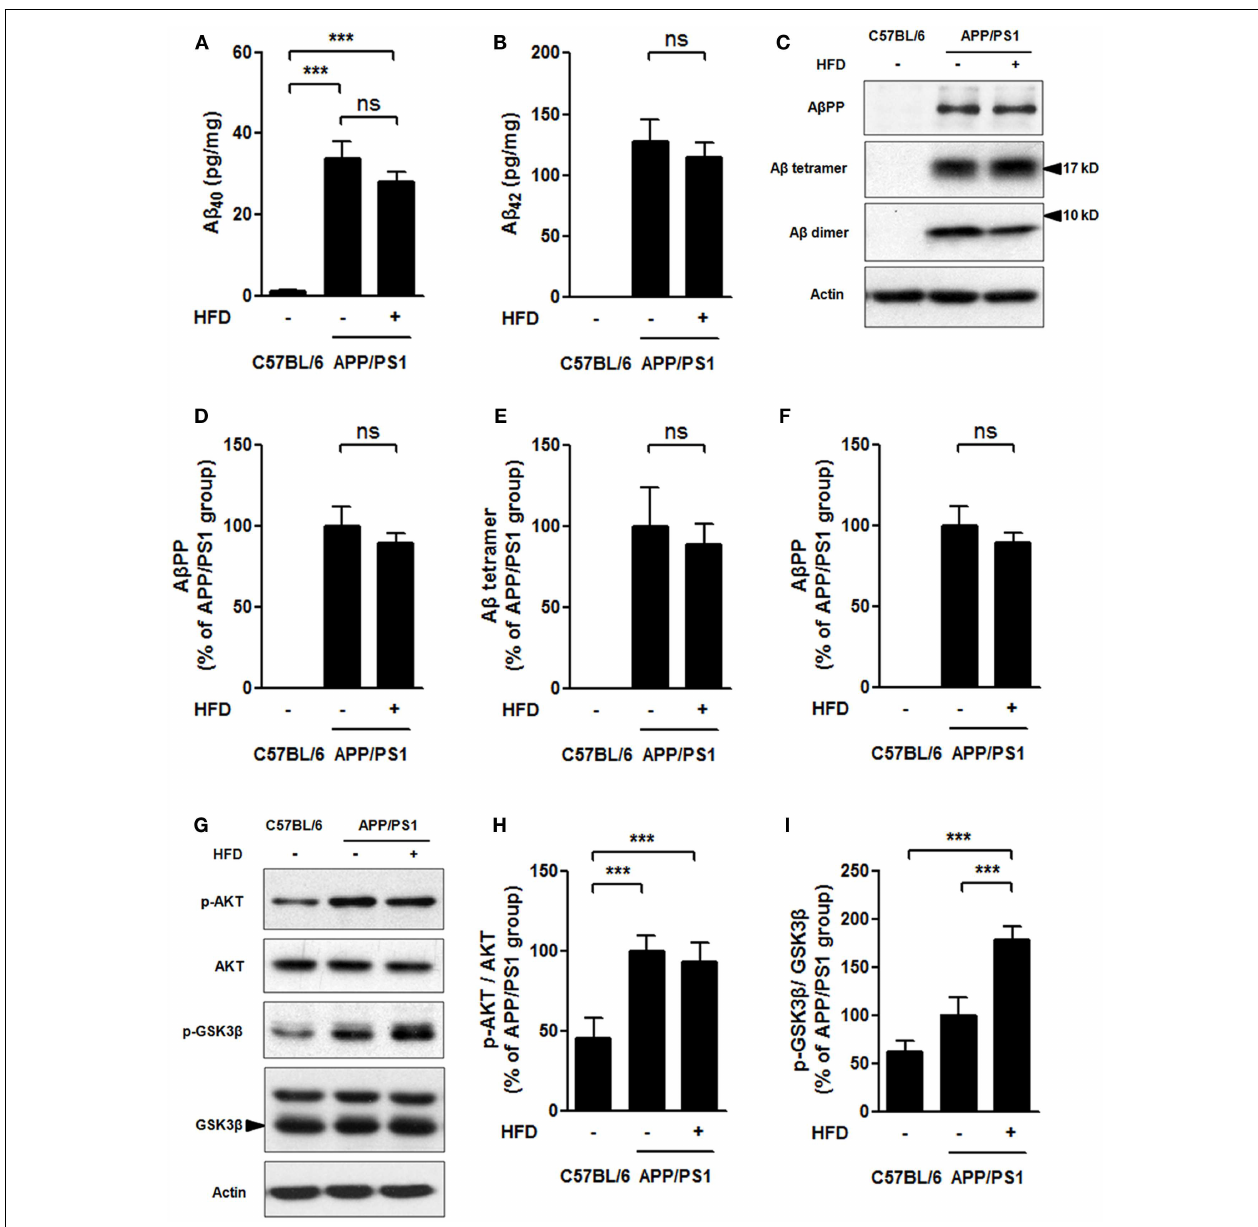
tissue were analyzed by western blot. Quantification of western blot of A β PP (D) , A β tetramer (E) , A β dimer (F) , p-AKT (H) , and p-GSK3 β (I) . Data were means ± SEM. n = 7 for C57BL/6 mice, n = 9 for APP/PS1 mice, and n = 8 for APP/PS1 + HFD mice.The results were analyzed by one-way ANOVA, followed by Newman–Keuls post hoc test. *** p <